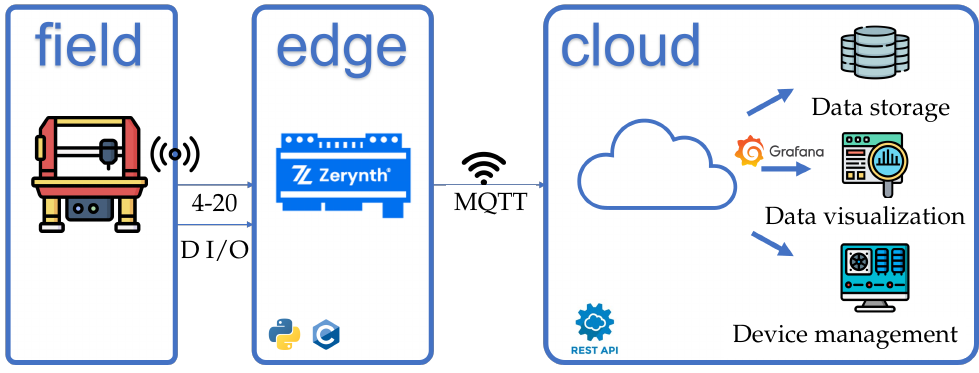
Figure 5. Final system overview.